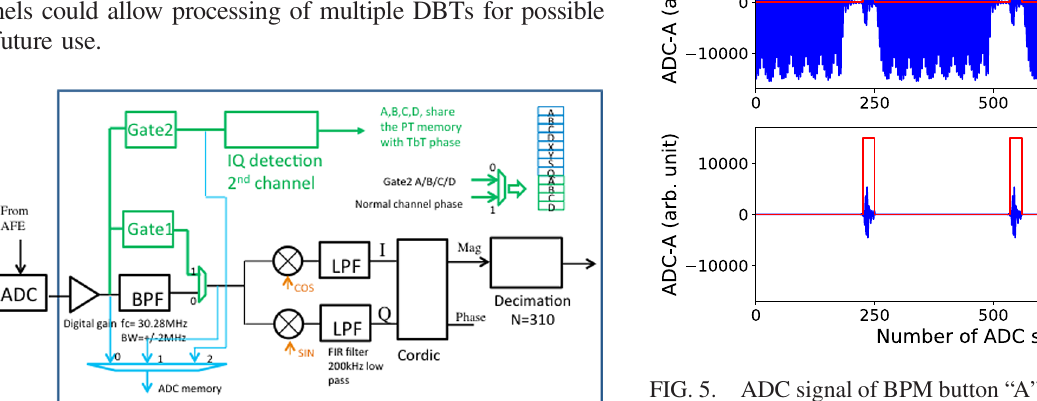
FIG. 5. ADC signal of BPM button “ A ” with and without gated functionality. Ungated BPM signals are the sum of contributions from all buckets (top). After applying a gated waveform as illustrated by the red lines, the DBT signals can be filtered out and processed by the newly added channel (Gate 2) as seen in Fig.